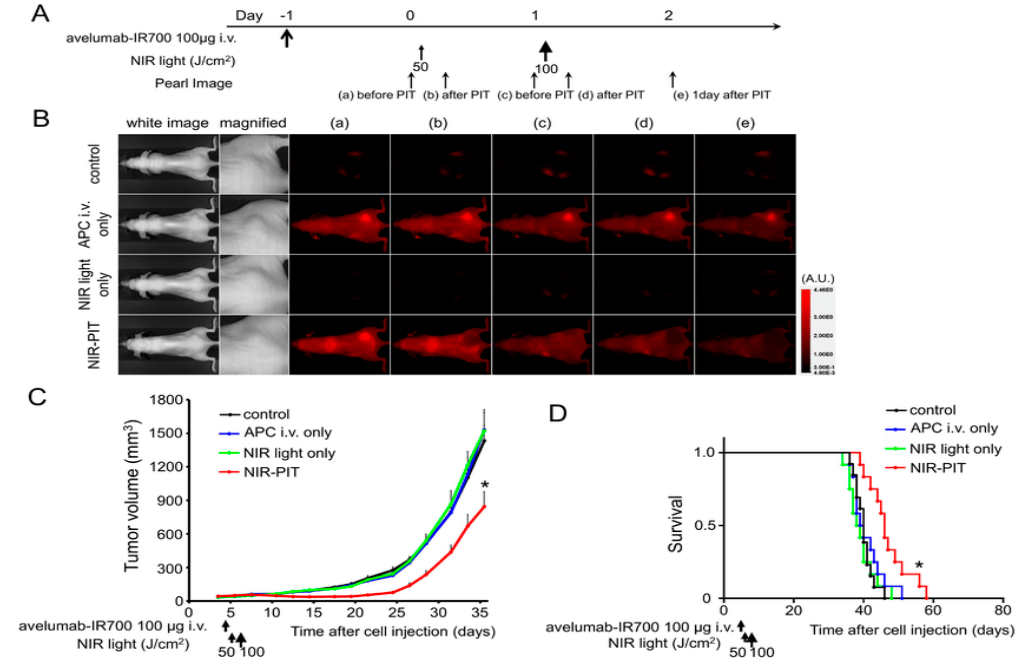
Figure 4. In vivo effect of NIR-PIT for treating animals bearing H441 lung cancer cells. ( A ) NIR-PIT injection regimen. ( B ) In vivo fluorescence real-time imaging of tumor-bearing mice in response to NIR-PIT. The tumors treated by NIR-PIT represented a decrease in IR700 fluorescence after NIR-PIT. ( C ) Tumor growth was substantially reduced in the NIR-PIT treatment groups. ( D ) Significantly prolonged survival was observed in the NIR-PIT treatment group. Reproduced from [75].